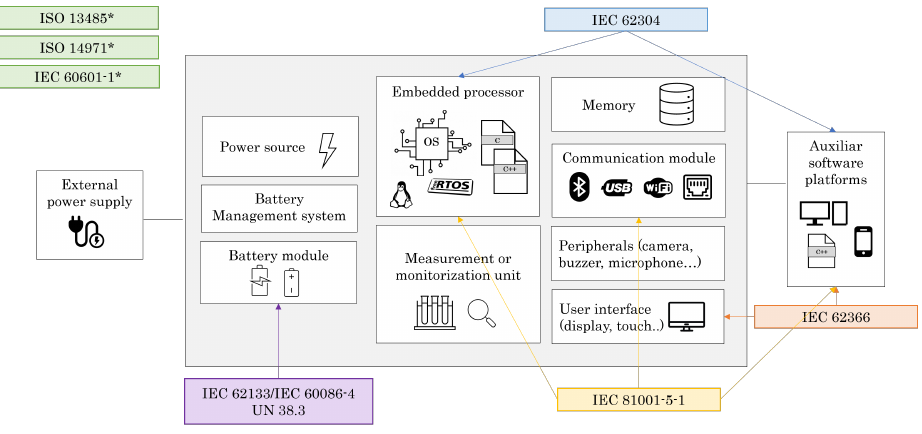
Figure 4. Embedded medical device modules and its regulations.